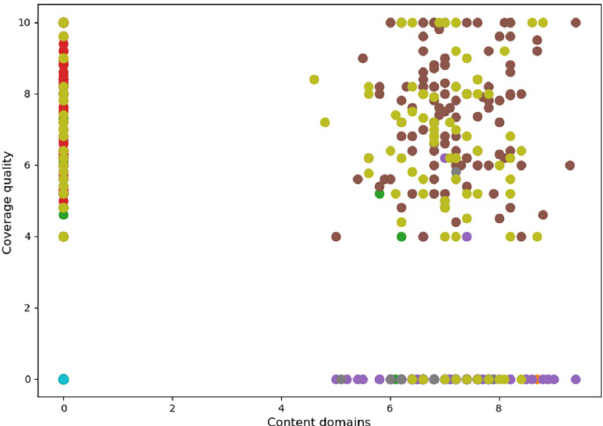
Figure 5. 10-means clustering of 1917 observations in the field of content domains and quality